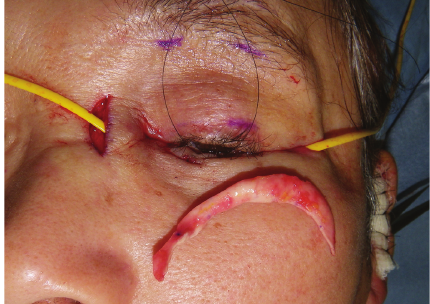
Figure 7: Intraoperative view of the second surgery (Case 2). Lower eyelid support with an auricular cartilage, and frontalis sling for upper eyelid ptosis.